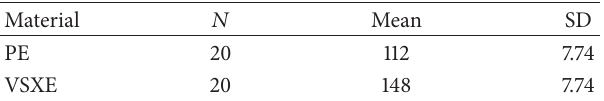
Table 2: Descriptive mean analysis of test impression materials ( 𝜇 m).